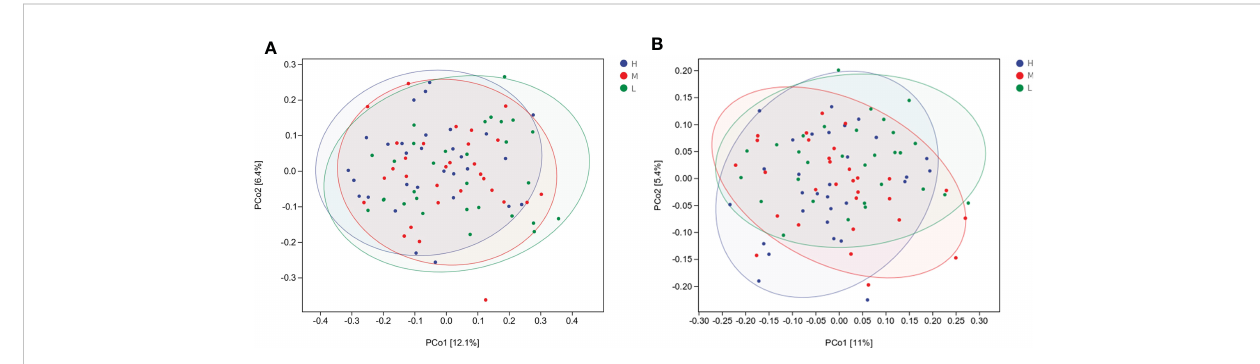
FIGURE 2 Microbial community composition in H, M and L groups evaluated by principal coordinate analysis (PCoA) based on beta diversity, including Bray_Curtis distances (A) , and Unweighted UniFrac distances (B)